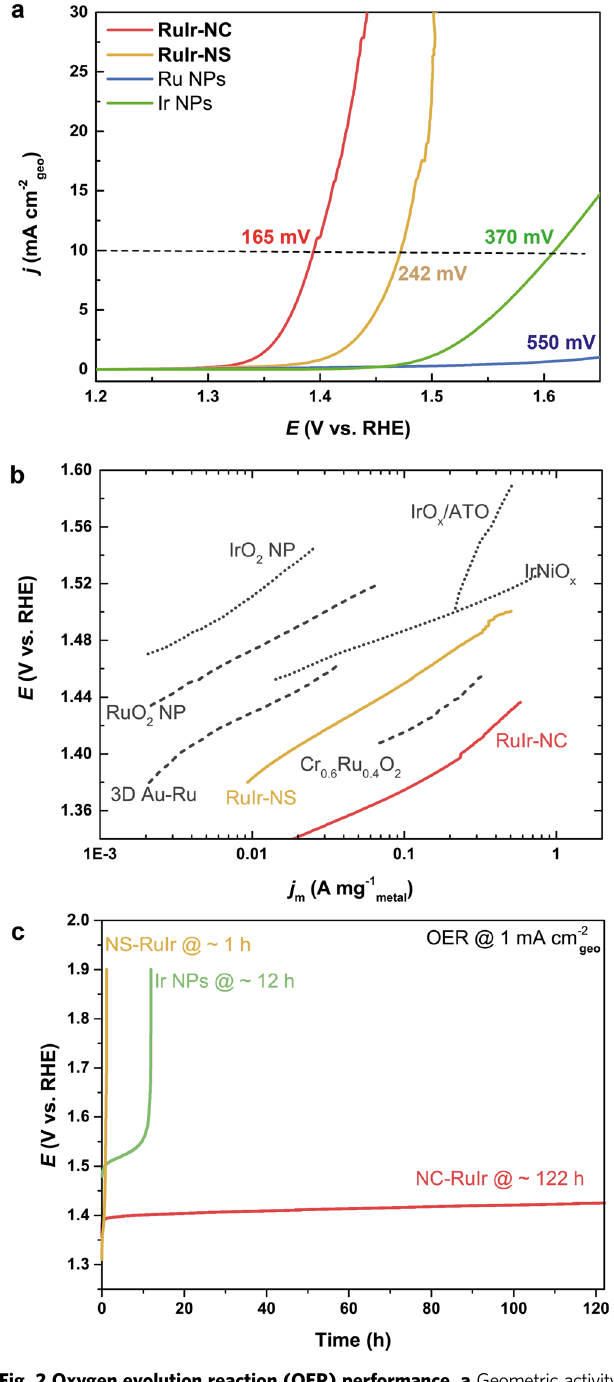
Fig. 2 Oxygen evolution reaction (OER) performance. a Geometric activity (current density normalized by electrode surface area) of RuIr catalysts (red for RuIr-NC and orange for RuIr-NS ) and pure Ru NPs (blue) and Ir NPs (green) (LSV pro fi les are obtained by cathodic scan). b Mass activity of RuIr-NC , RuIr- NS and the reported high-performance catalysts with considerable stability in acid including RuO 2 NP 26 , IrO 2 NP 26 , IrO x -ATO 23 , 3D Au – Ru 46 , IrNiO x 6 and Cr 0.6 Ru 0.4 O 2 27 . The mass activities are normalized by the mass of noble metals. c Chronopotentiometric curves under the OER current density of 1mAcm − 2 geo